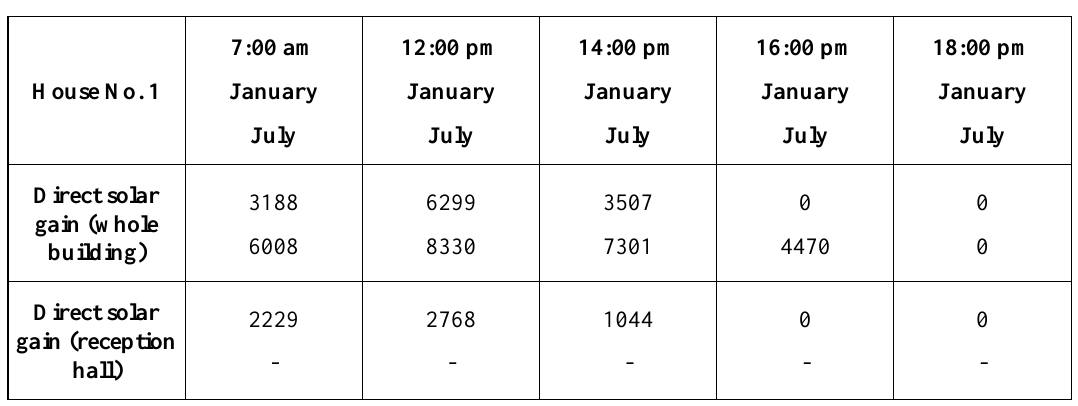
Table 5 Direct solar gain of house No.1 (unit: W.h) (Data done in Ecotect, Source: Author)